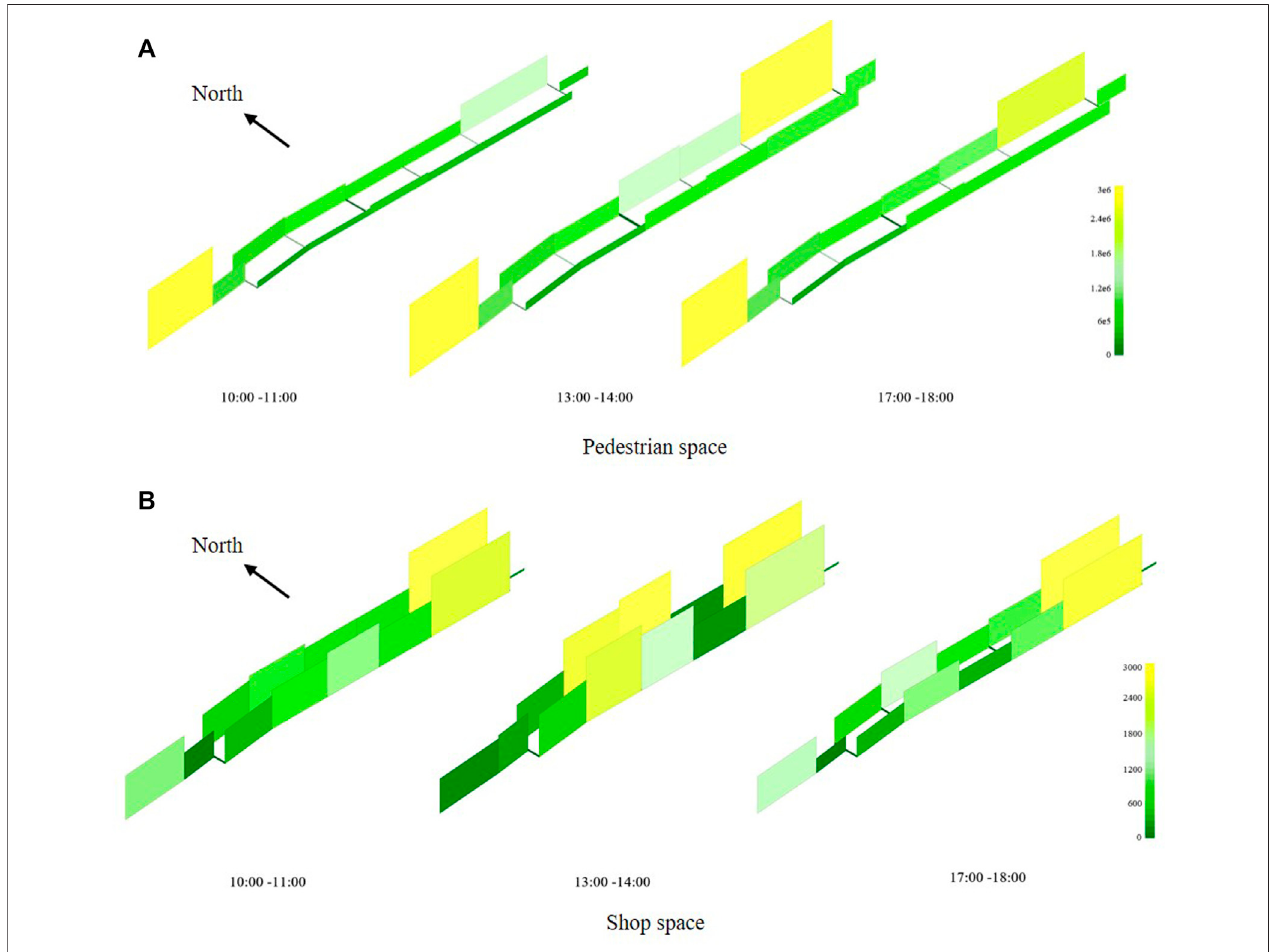
FIGURE 8 | Spatiotemporal distribution of cumulative exposure duration in the study area: (A) pedestrian space; (B) shop space.